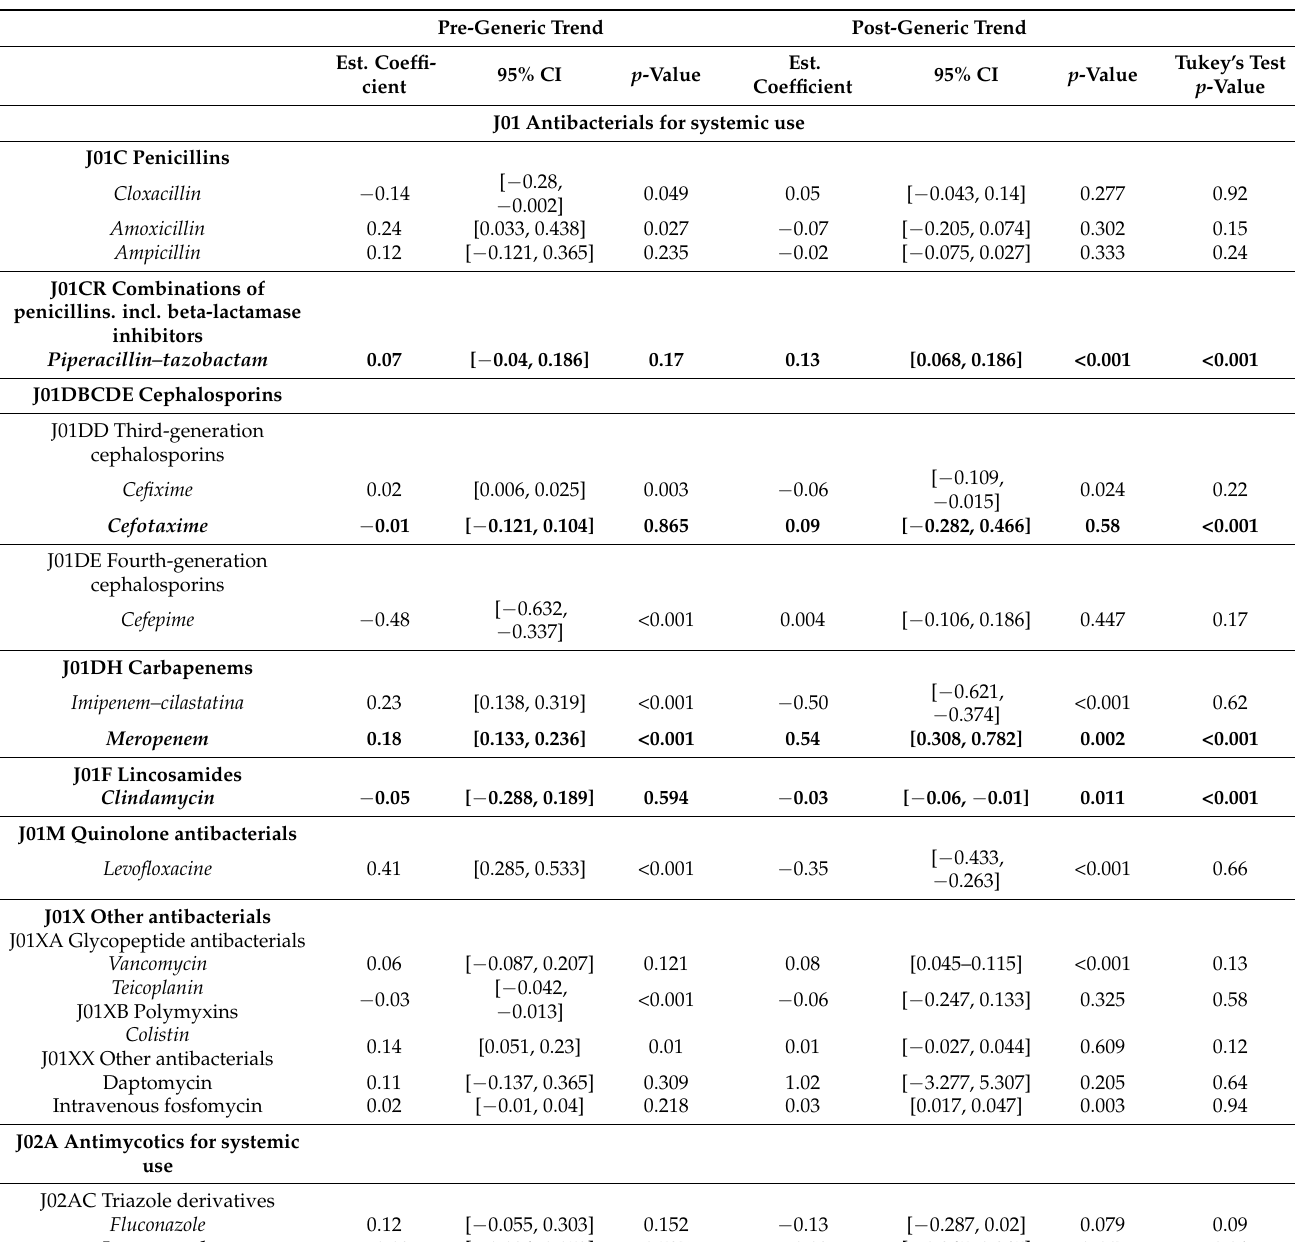
Table 1. Antimicrobial consumption trends before and after generic